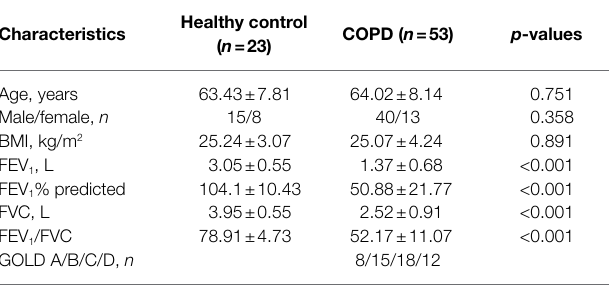
BMI, body mass index; FEV 1 , forced expiratory volume in 1 s; FEV 1 % pred, FEV percentage predicted; FVC, forced vital capacity; and GOLD, the global initiative for chronic obstructive lung disease.